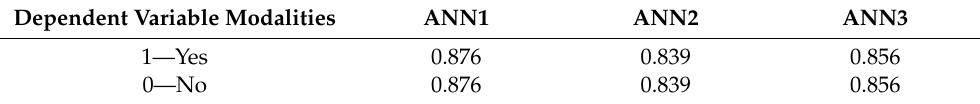
Table 6. The area under the curve.